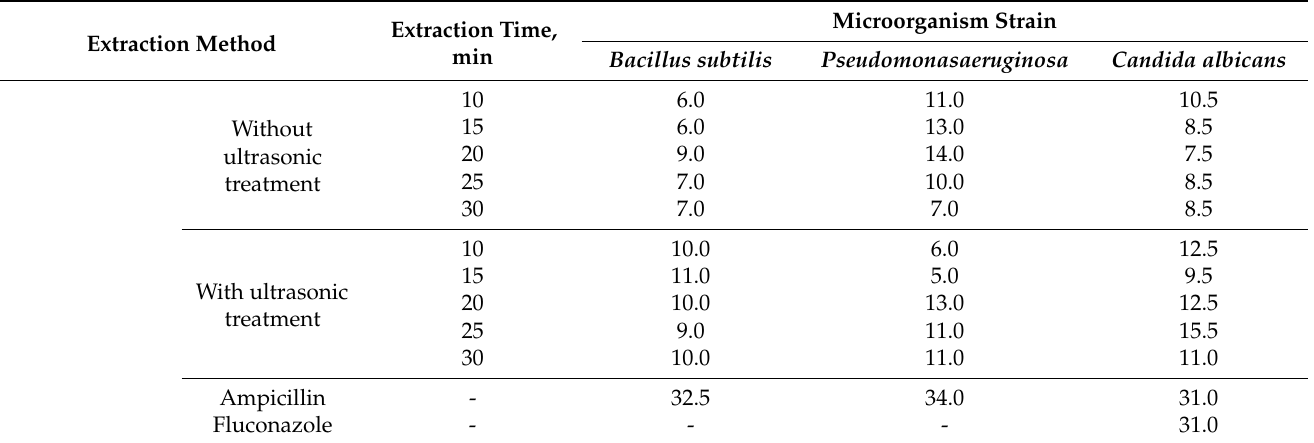
Table 1. Inhibition zone of Eucalyptus globulus extracts and ampicillin against various strains of